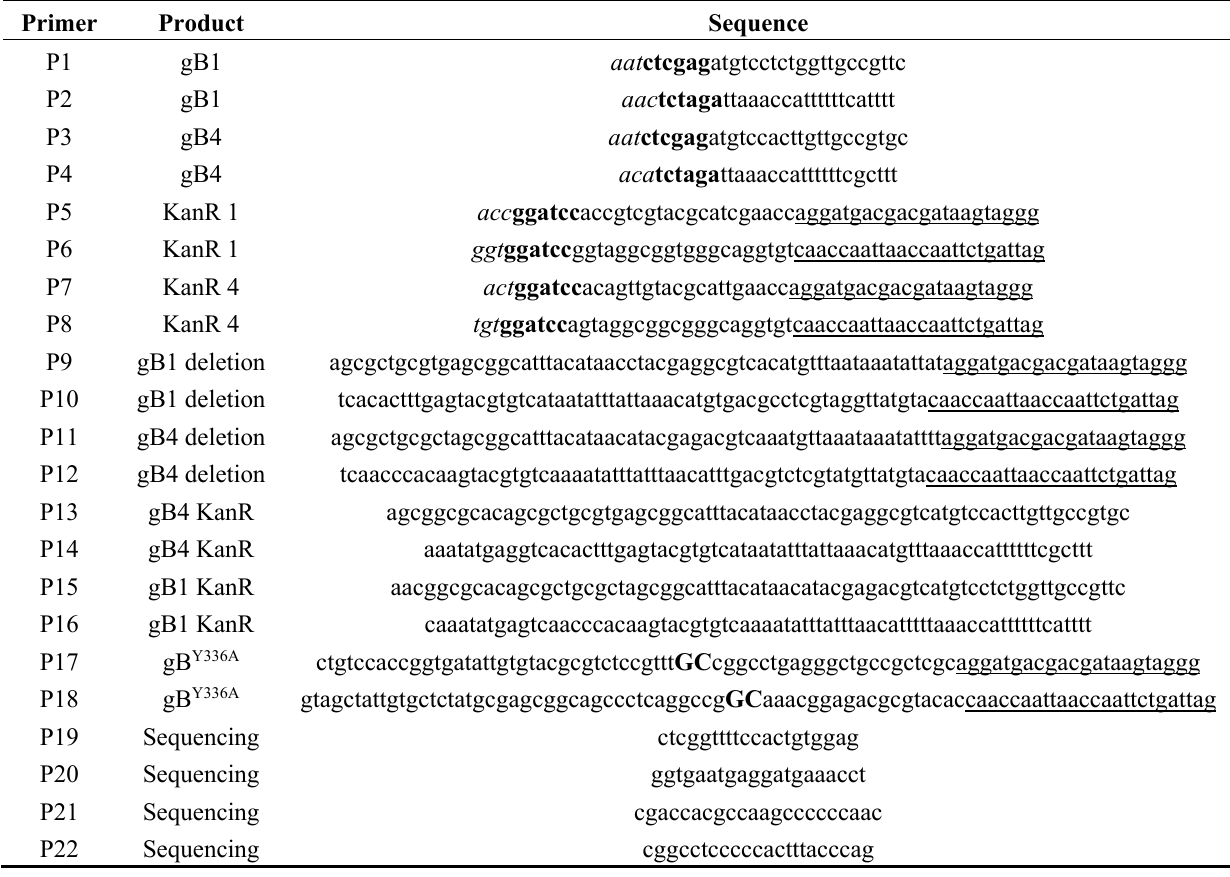
Table 1. Oligonucleotide primers used in this